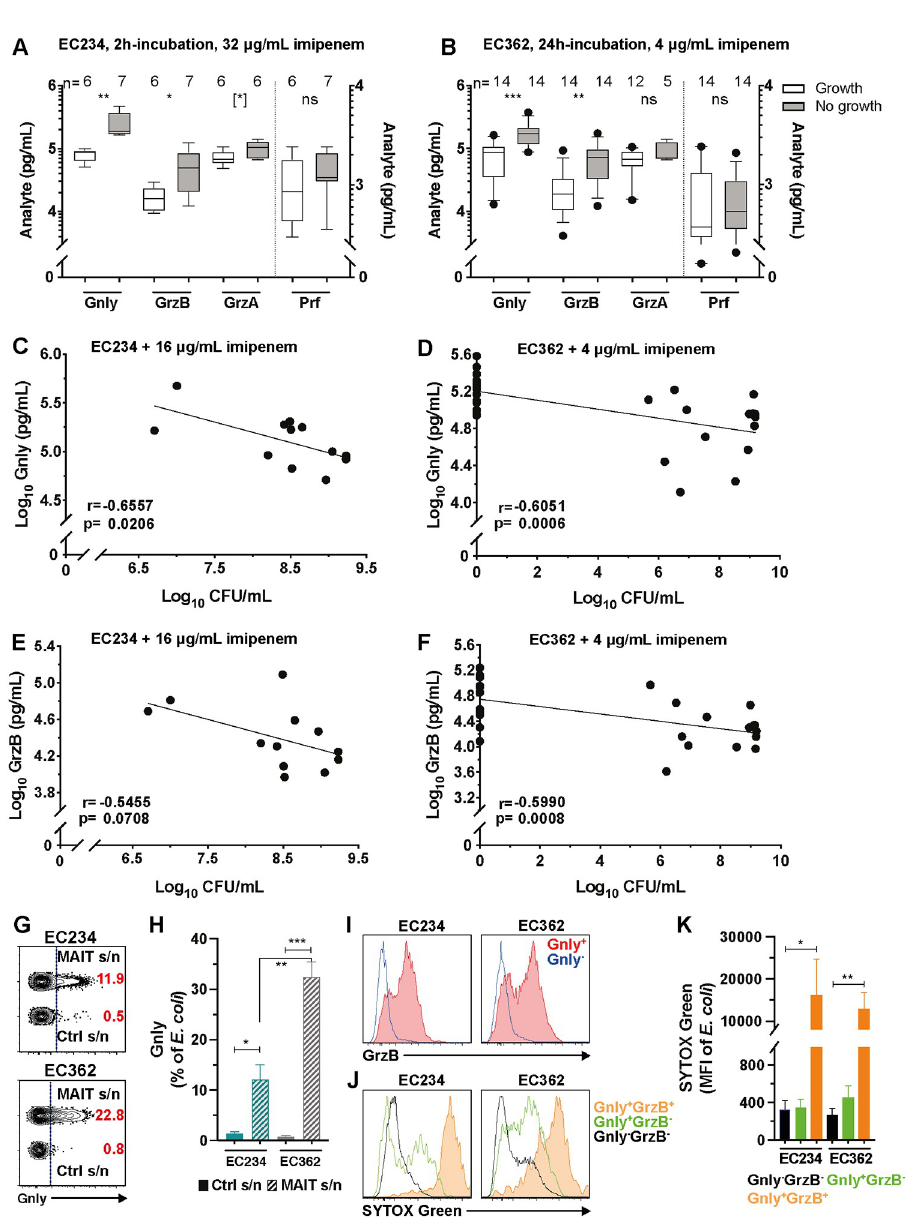
Fig 5. Cytolytic proteins contribute to the antimicrobial activity of MAIT cell secretomes. (A, B) Concentration of cytolytic proteins in the MAIT cell supernatants spiked with imipenem in the E . coli EC234 ( n = 12) and EC362 ( n = 28) cultures in which growth was detected or not at the indicated time points. (C, D) Correlation between Gnly and (E, F) GrzB levels in the MAIT cell supernatants and E . coli EC234 and EC362 bacterial loads after 24 h incubation in the MAIT cell supernatants spiked with imipenem. (G) Gating strategy of Gnly flow cytometry staining and (H) proportion of Gnly in E . coli EC234 ( n = 4) and EC362 ( n = 6) following 30 min incubation with MAIT cell or control supernatants. (I) Representative histograms of GrzB, and (J) SYTOX Green staining and (K) intensity in E . coli EC234 ( n = 4) and EC362 ( n = 6) following 30 min incubation in MAIT cell or control supernatants. Data presented as bar graphs with error bars represent the mean and standard error. Box and whisker plots show median, the 10th to 90th percentile, and the interquartile range. Statistical significance was determined using the Mann-Whitney test (A, B), paired t test for intrastrain or unpaired t test for interstrain analyses (H), and Friedman’s test with Dunn’s post hoc test (K). Correlations were calculated using the Pearson test (C, E) and the Spearman test (D, F). ��� p < 0.001, �� p < 0.01, � p < 0.05, [ � ] p < 0.1. The underlying data of this figure can be found in S1 Data. CFU, colony-forming units; Gnly, granulysin; Grz, Granzyme; MAIT, Mucosa-associated invariant T; MFI, mean fluorescence intensity; ns, not significant; Prf, perforin; s/n,